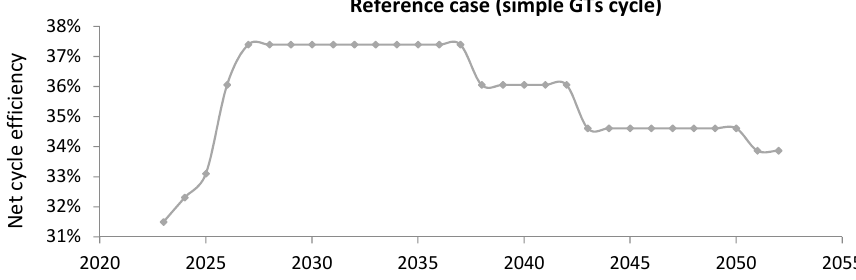
Figure 11. Performances of simple gas turbines cycle.